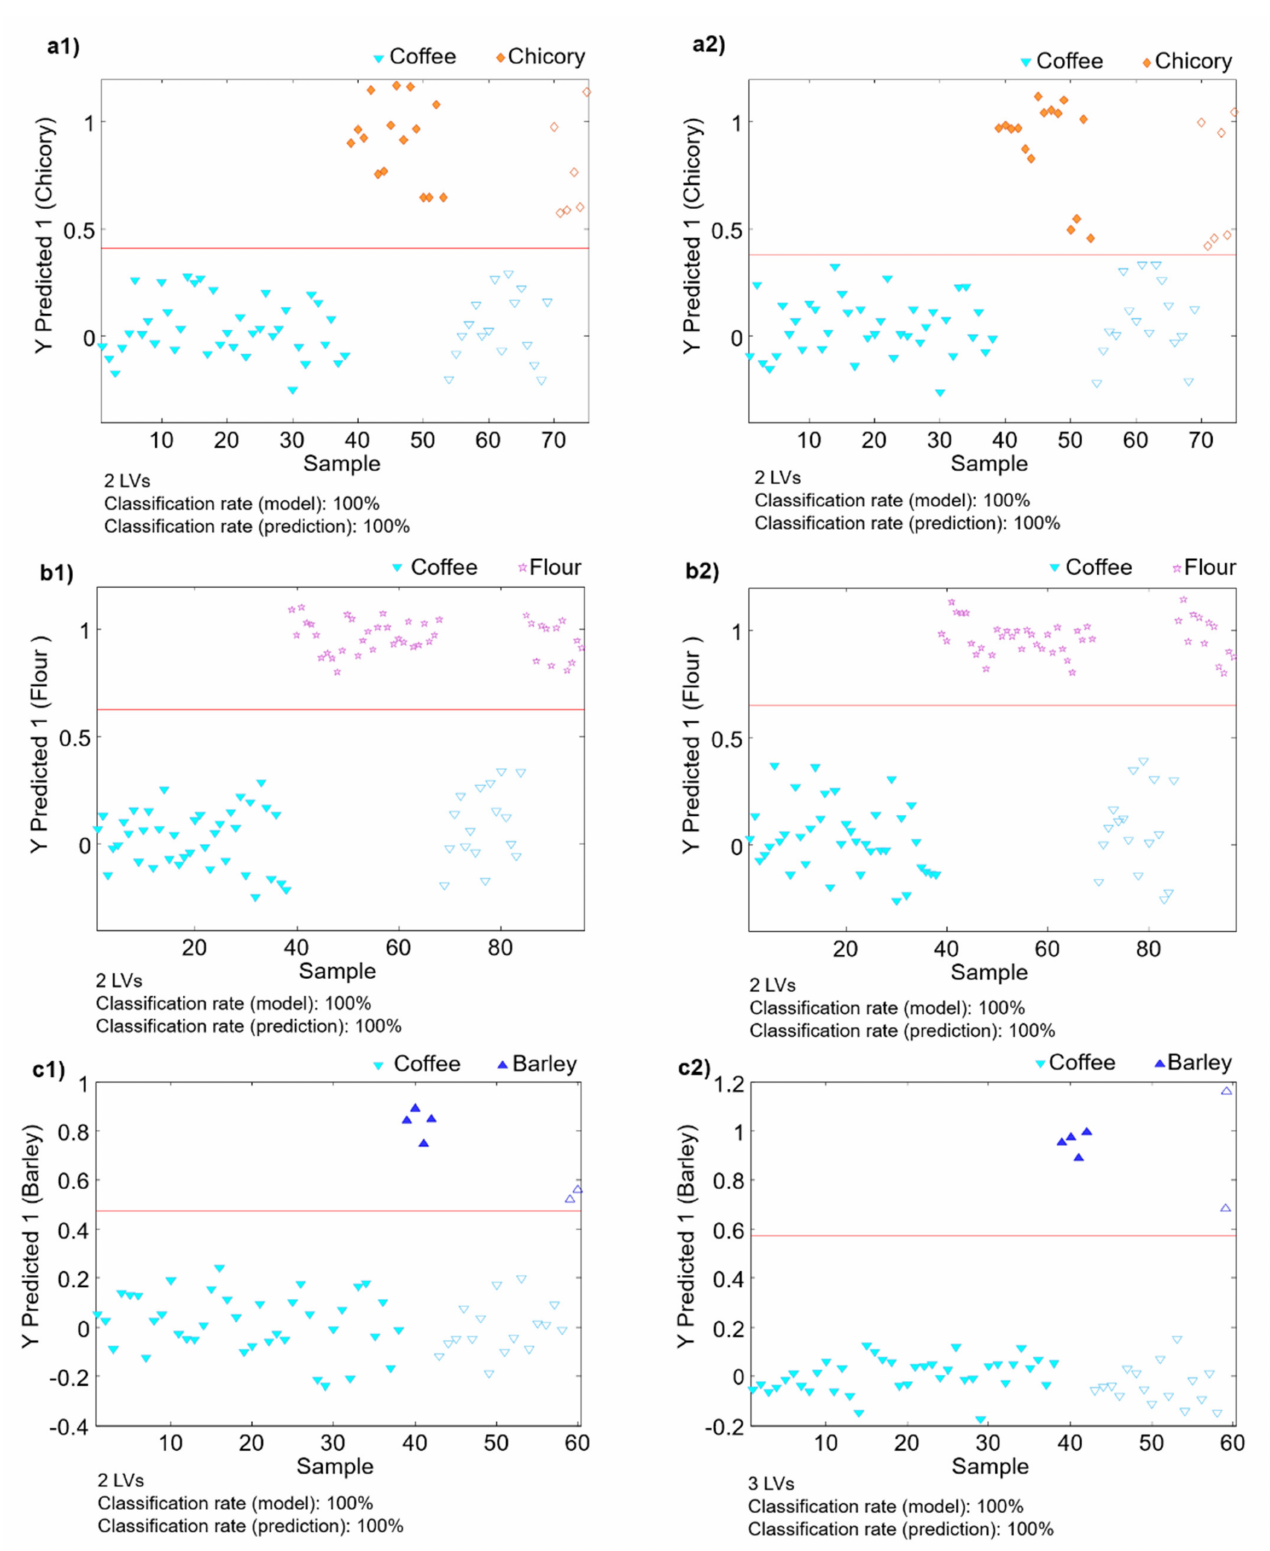
Figure 4. Classification plots defined by the sample vs. the predicted classes when (1) HPLC-UV (2) HPLC-FLD fingerprints were used as sample chemical descriptors. ( a ) Coffee vs. chicory samples, ( b ) coffee vs. flour samples, and ( c ) coffee vs. barley samples. Filled symbols correspond to the calibration set and empty symbols correspond to the validation set (unknown samples for prediction